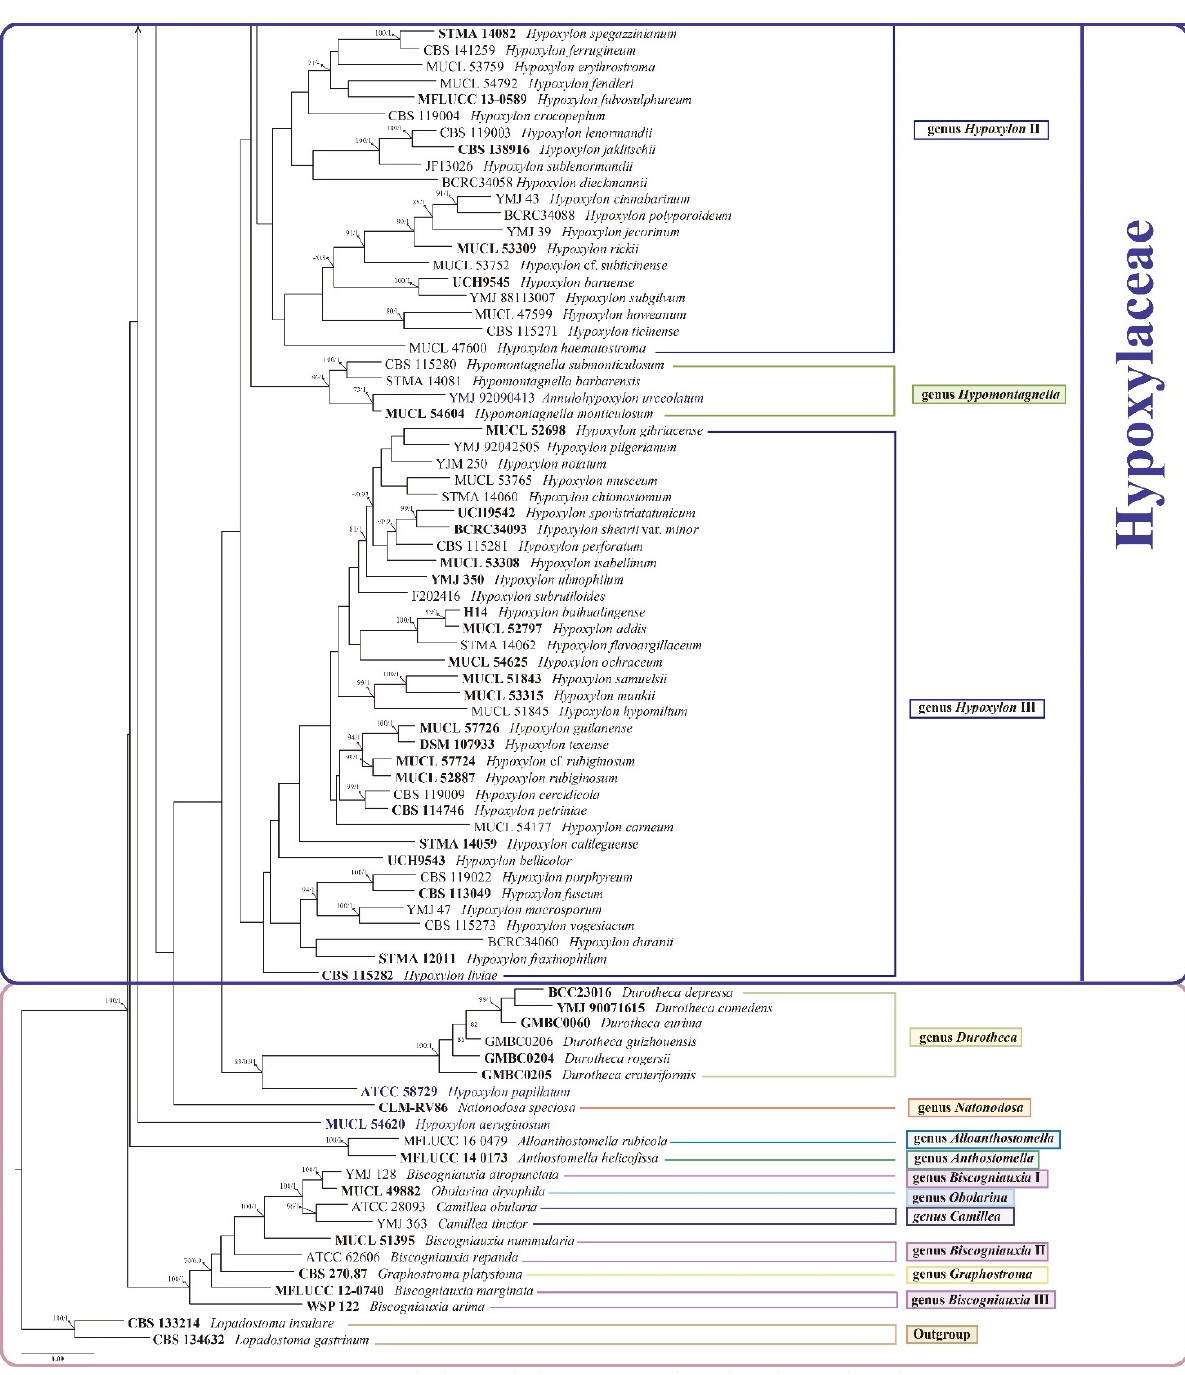
Figure 2. A multi-locus phylogenetic tree based on the combined ITS-LSU-TUB2-RPB2 sequences of related Xylariales species resulting from a maximum likelihood phylogenetic analysis. The tree is rooted at the outgroup Lopadostoma gastrinum (CBS 134632) and Lopadostoma insulare (CBS 133214). The isolates from this study are in red (new species) and green (known species). Strains needing reevaluation are in purple. Different aggregate partition is based on their various stromata, mainly represented by several Xylaria species following Hsieh et al. 2010. The ex-type isolates are in bold. Equal or greater than 70% maximum likelihood values (ML) and/or 0.9 Bayesian posterior proba- bilities (BPP) are labelled at the end of nodes. Dashes are indicated values lower than 70% ML and/or 0.9BPP. Scale bar corresponds to 0.09 substitutions per site.